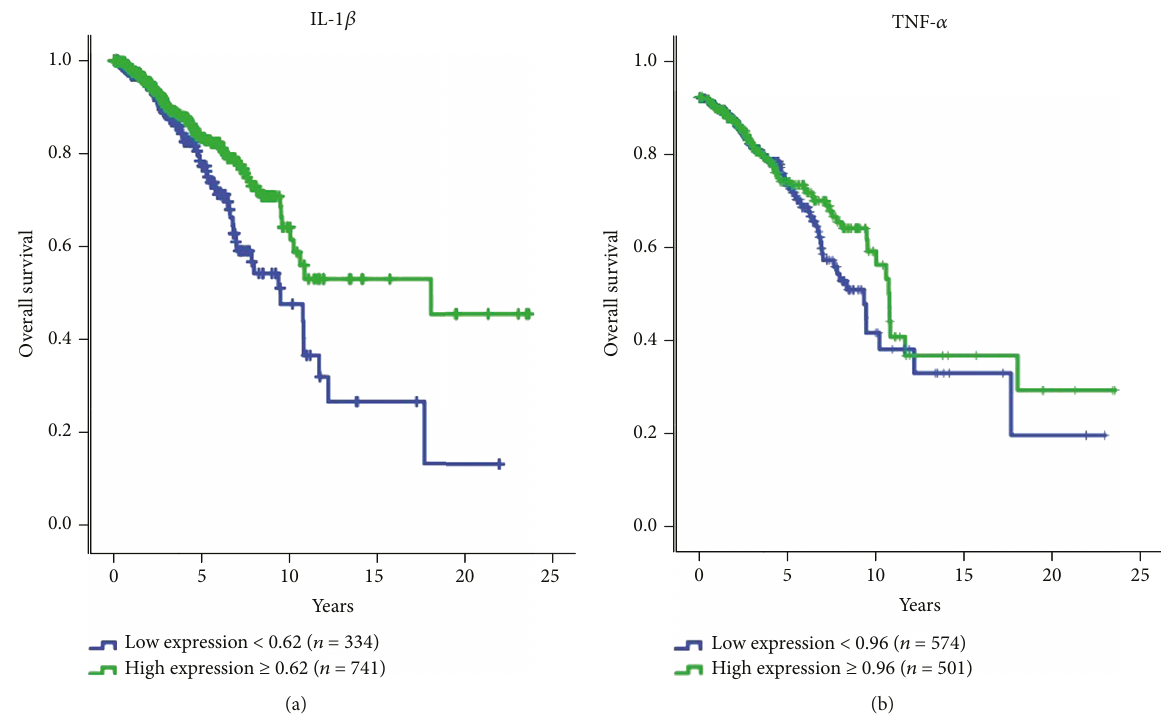
Figure 3: IL-1 β and TNF- α expression in breast cancer patients. Kaplan-Meier plots showing the overall survival analysis of breast cancer patients according to IL-1 β (a) and TNF- α (b) expression levels from TCGA